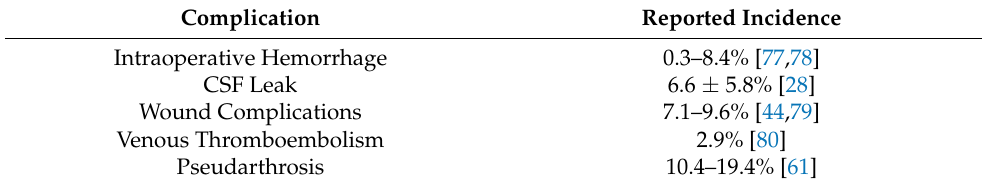
Table 1. Reported incidences for complications of spinal tumor